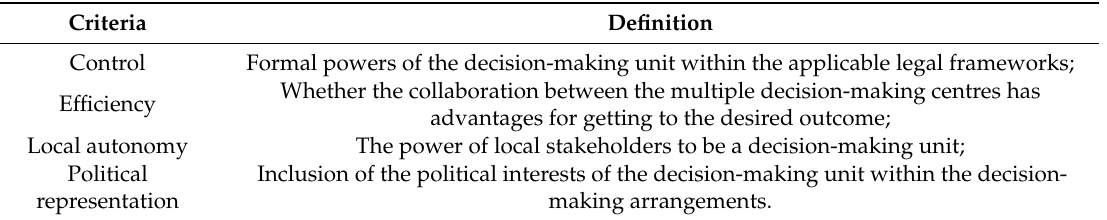
Table 2. Criteria for evaluating the functioning of polycentric decision-making systems